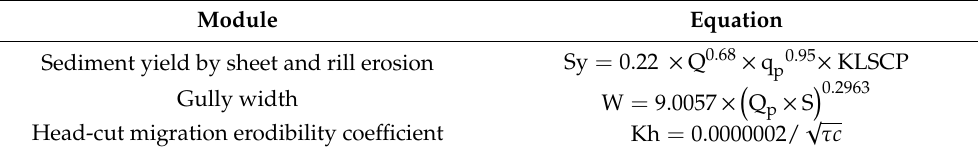
Table 1. Equations and parameters used to simulate soil erosion in the AnnAGNPS model. Module